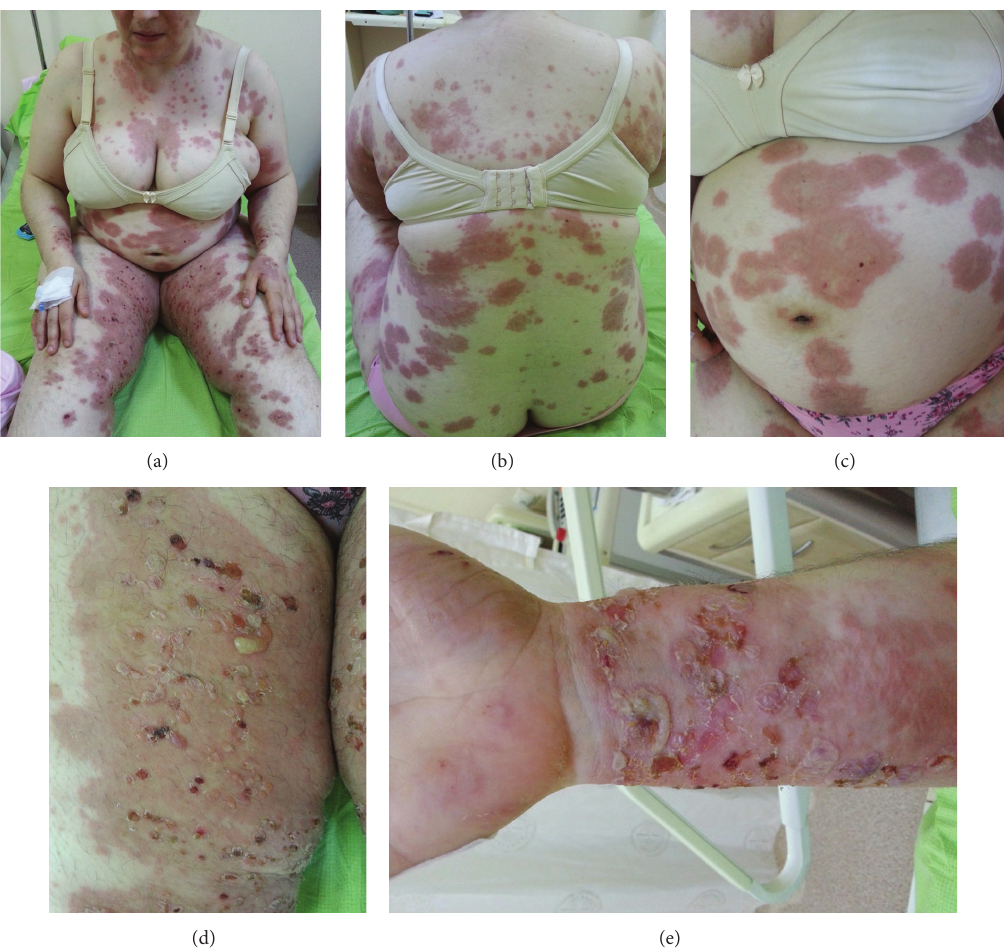
Figure 1: Macroscopic skin lesions of a 33-week pregnant woman with pemphigoid gestationis. (a) Macular, confluent, pruritic lesion in the abdomen and arms. (b) On the back. (c) On the abdomen. (d) Many tense and collapsed bullae on the leg. (e) Collapsed bullae on the forearm.